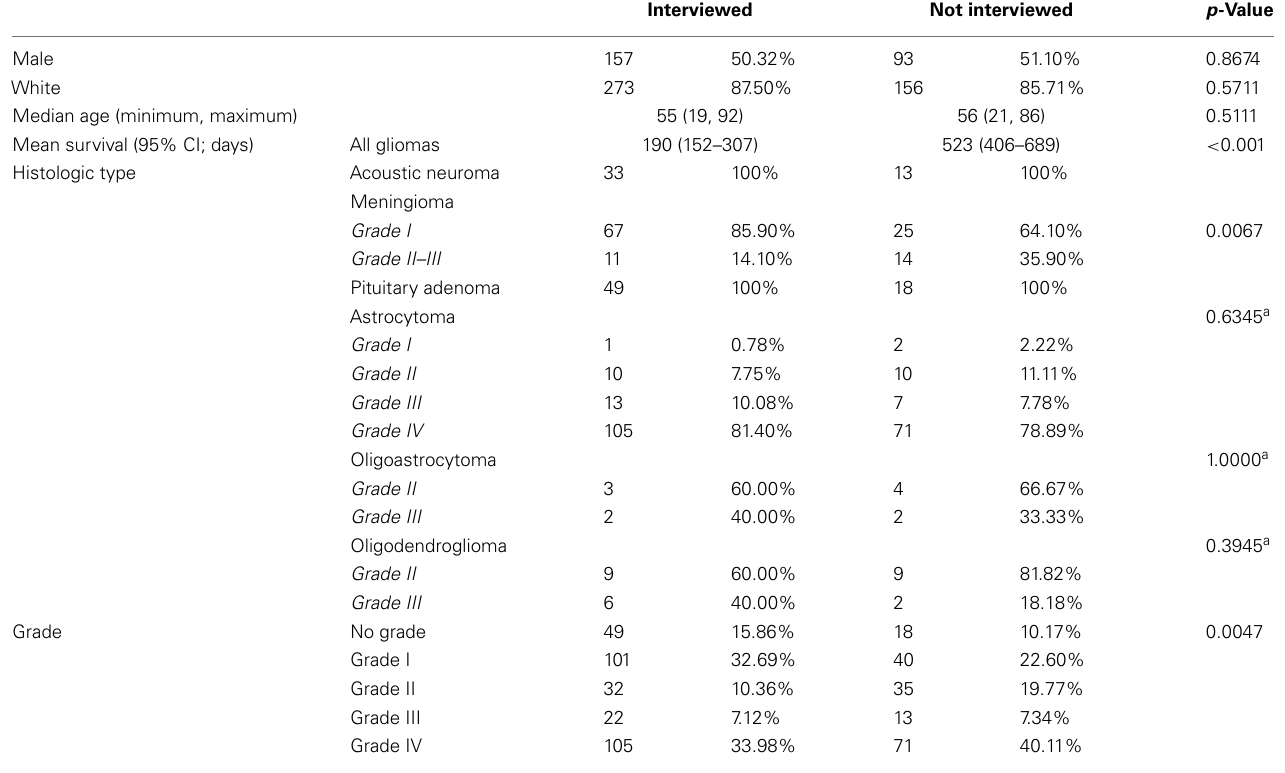
Table 5 | Characteristics of interviewed and non-interviewed